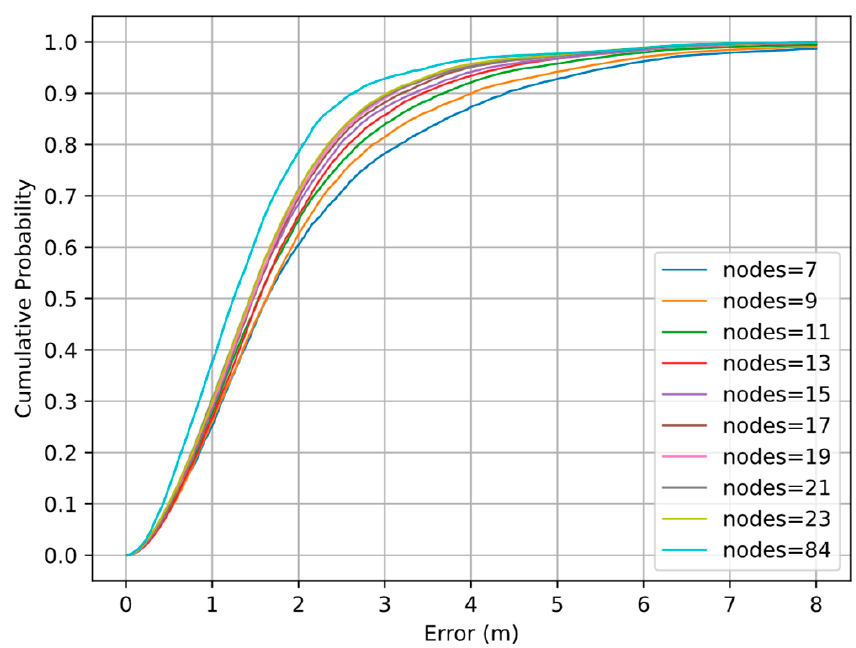
Figure 10. Positioning error cumulative distribution function (CDF) curves of different numbers of nodes.